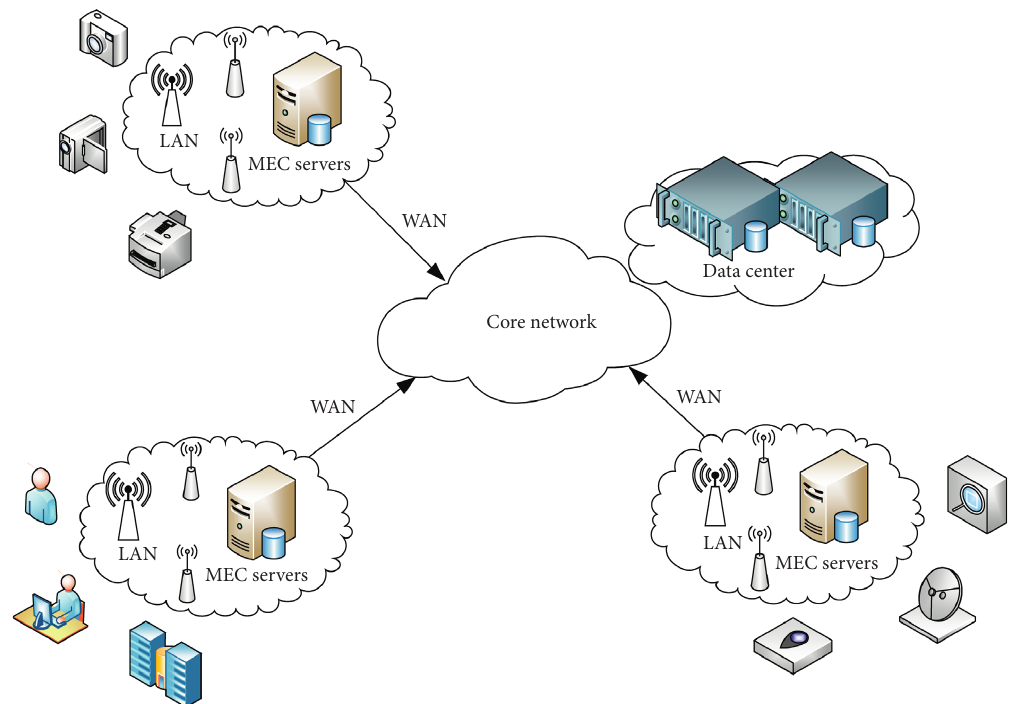
Figure 1: Multicloudlet